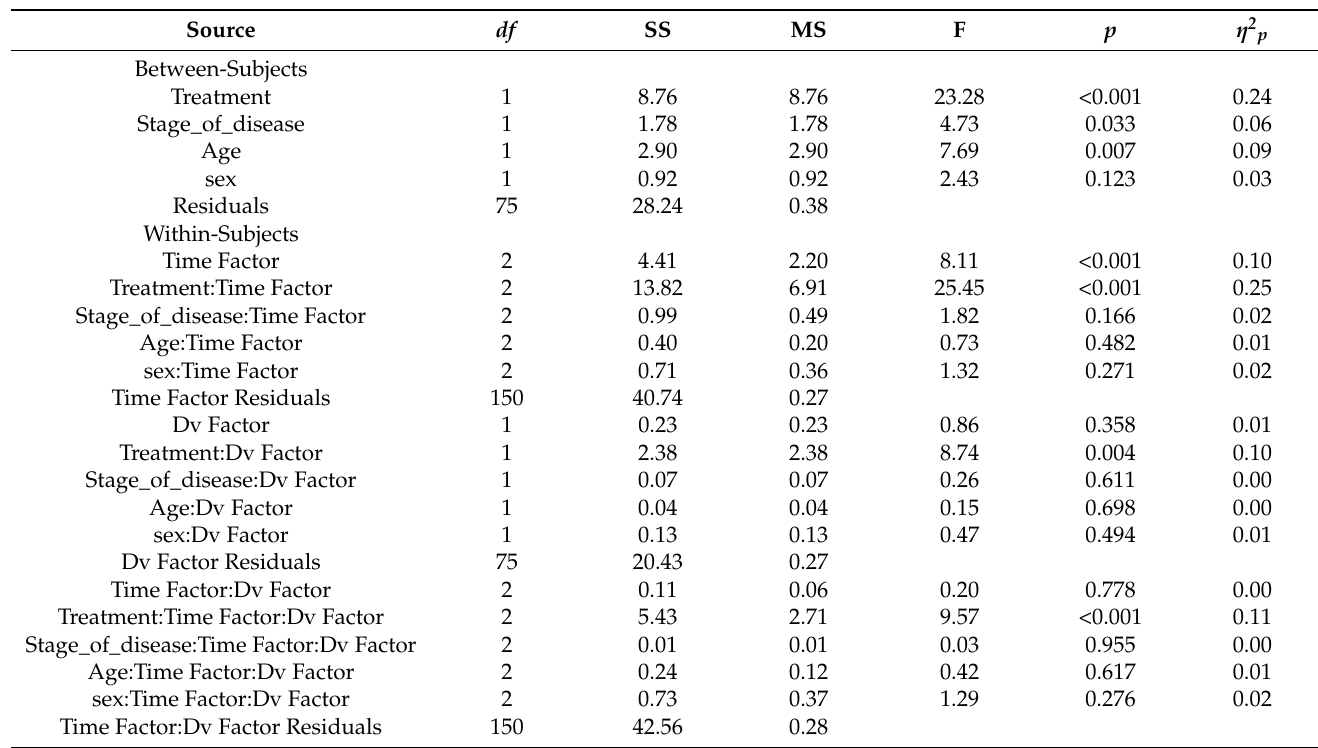
Table 6. Mixed Model MANCOVA